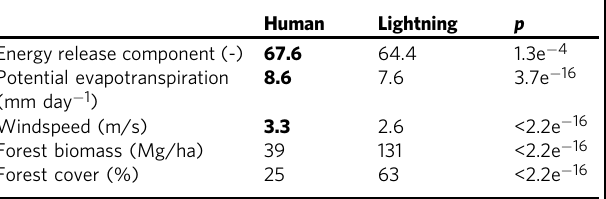
Table 1 Mean environmental conditions on the ignition day for human- and lightning-caused fi res in FRAP across California (2012 – 2018).